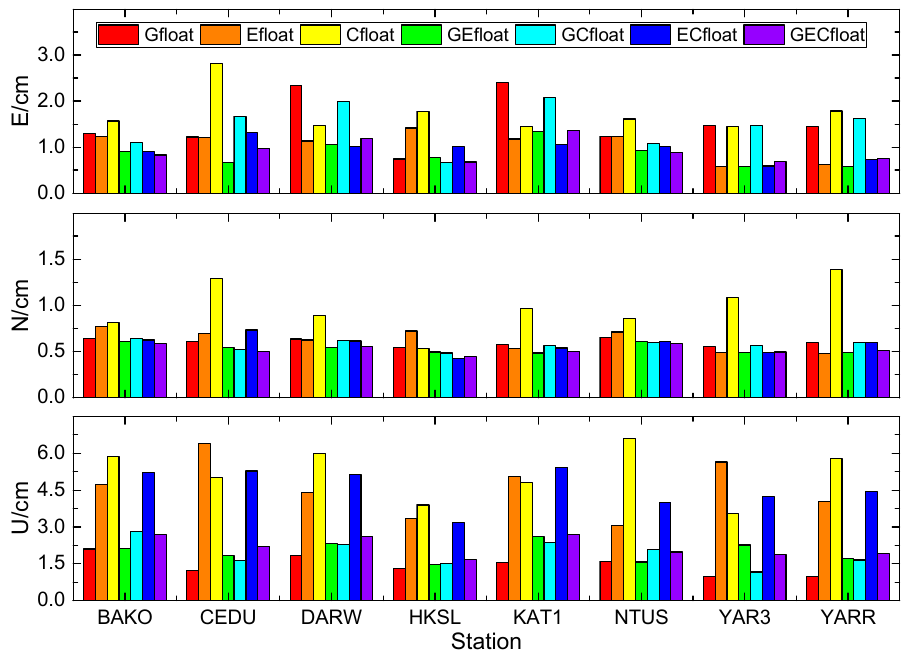
Figure 12. The average RMS of float PPP solution from DOY 321 to 350, 2018.